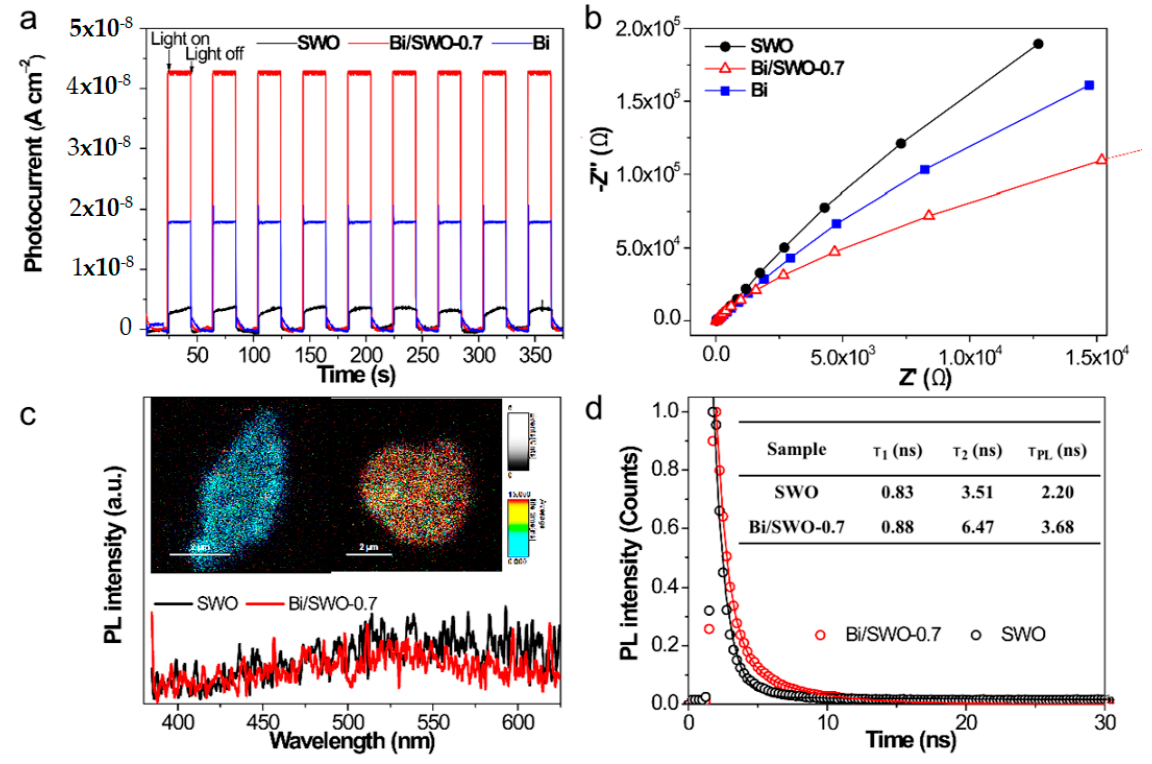
Figure 5. Transient photocurrent response ( a ) and electrochemical impedance spectra ( b ) of Bi, SWO and Bi/SWO-0.7. The single-particle PL images (inset) and PL spectra ( c ), and the time-resolved fluorescence decay spectra ( d ) between SWO and Bi/SWO-0.7. The solid curves indicate the multi-exponential curves fitted to the kinetic traces using biexponential decay function.